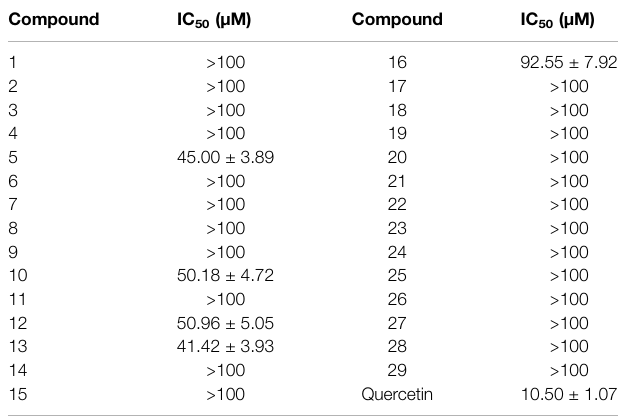
TABLE 3 | Cytotoxic activities of compounds 1 – 29 on BV2 Cells (IC Compound